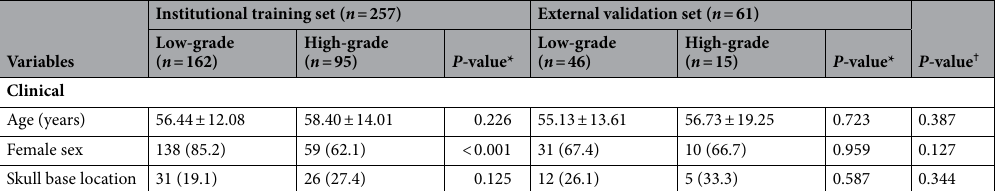
Table 1. Patient characteristics in the institutional training and external validation sets. Data are expressed as mean with standard deviation in parentheses or number with percentage in parentheses. *Calculated from Student’s t -test for continuous variables and Chi-square test for categorical variables to compare the characteristics between low-grade and high-grade patients of the institutional cohort and the external validation set. ✝ Calculated from Student’s t -test for continuous variables and Chi-square test for categorical variables for comparison of institutional training and external validation sets.